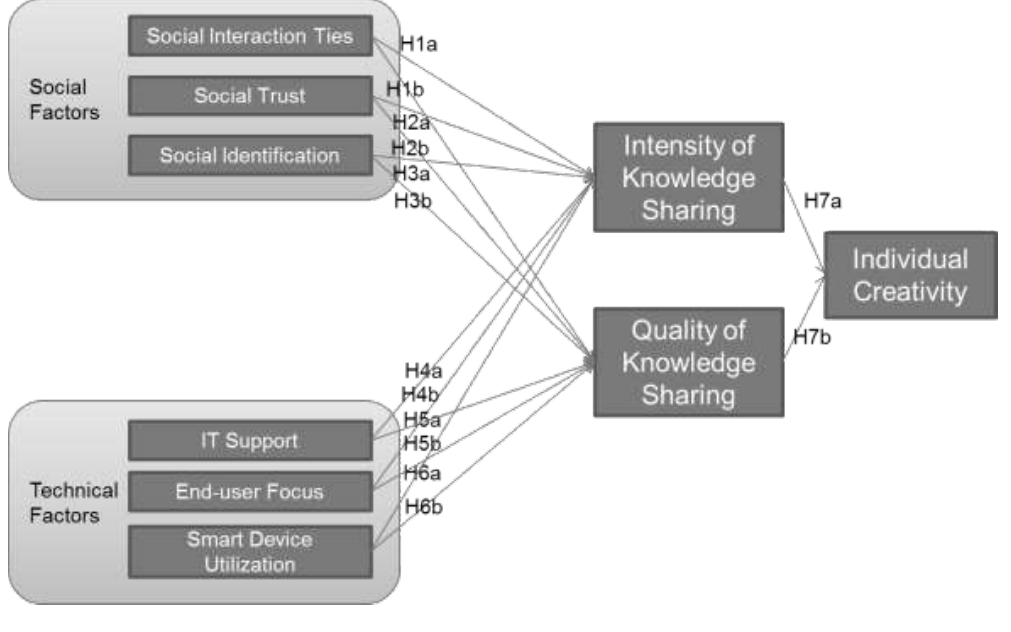
Figure 1. Research model.